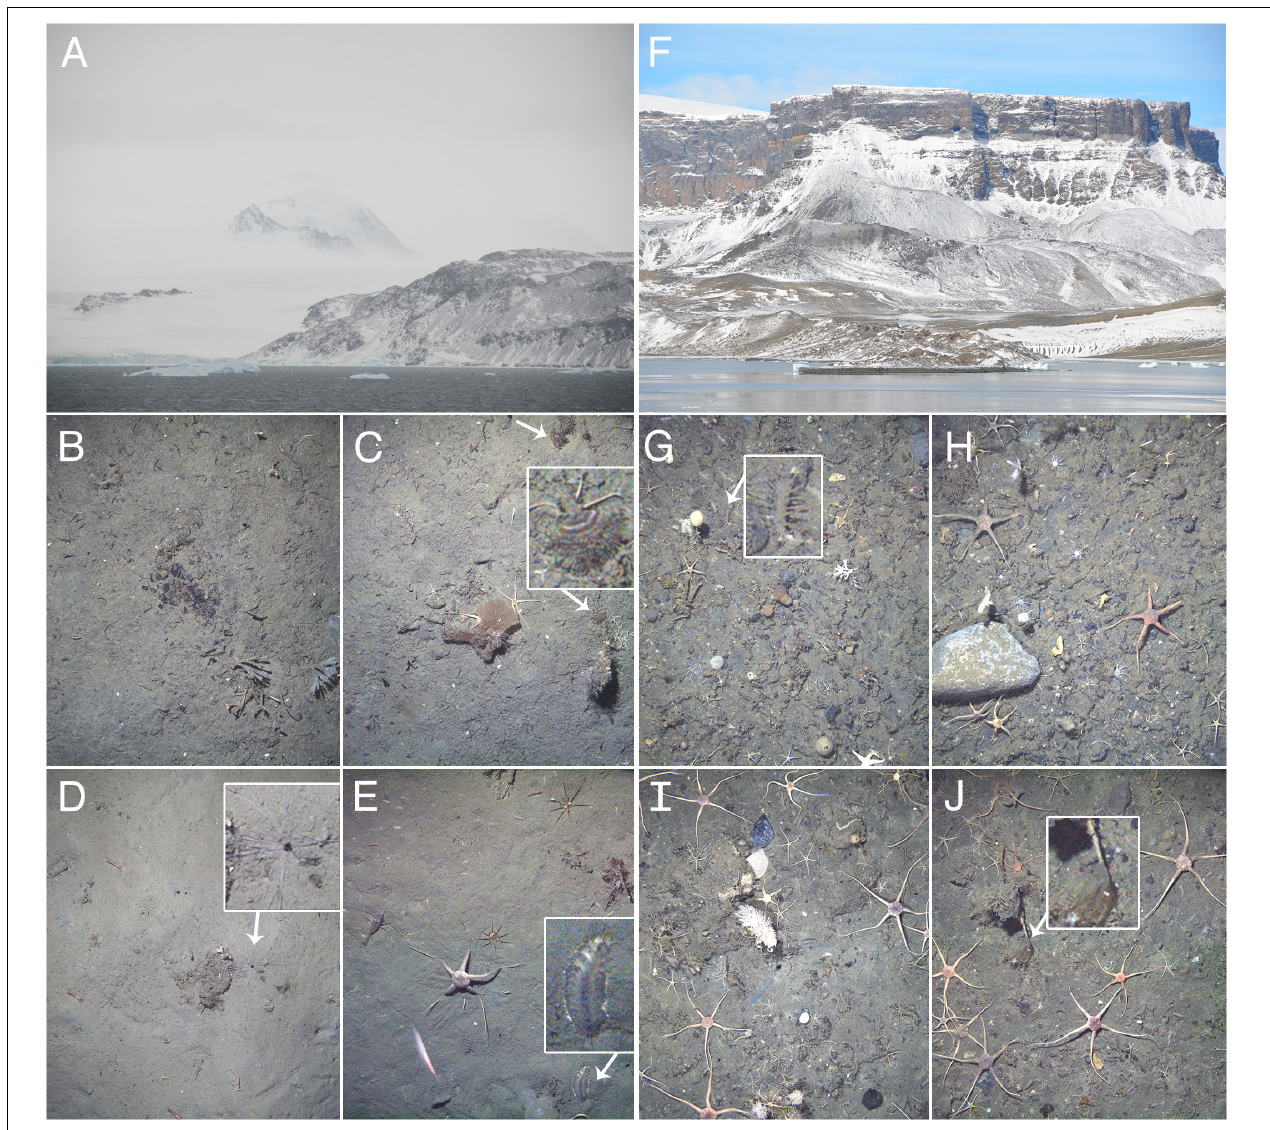
FIGURE 2 | Overview of sites within the Prince Gustav Channel (PGC) including Shallow-water camera system (SUCS) imagery of localities corresponding to AGT sampling sites. (A–E) Duse bay sites, (F–J) PGC sites. SUCS imagery for deepest sites (Duse Bay 1000 m and PGC South 1200 m) was not available due to depth limitations. (A) Above water image of Duse Bay (image credit Angelika Brandt); (B) SUCS event no. 15, Duse Bay 200 m site; (C) SUCS event no. 15, Duse Bay 200 m site, with detail of sabellidae polychete; (D) SUCS event no. 11, Duse Bay 500 m site, with detail of terebellid polychete; (E) SUCS event no. 11, Duse Bay 500 m site, with detail of polynoid polychete, possibly Austrolaenilla antarctica (see Figure 4D ); (F) Above water image of the Prince Gustav Channel (image credit Angelika Brandt); (G) SUCS event no. 45, PGC Mid 850 m site, with detail of flabelligerid polychete, possibly Flabegraviera mundata (see Figure 3B ); (H) SUCS event no. 45, PGC Mid 850 m site; (I) SUCS event no. 22, PGC South 800 m site; (J) SUCS event no. 22, PGC South 800 m site, with detail of sabellid